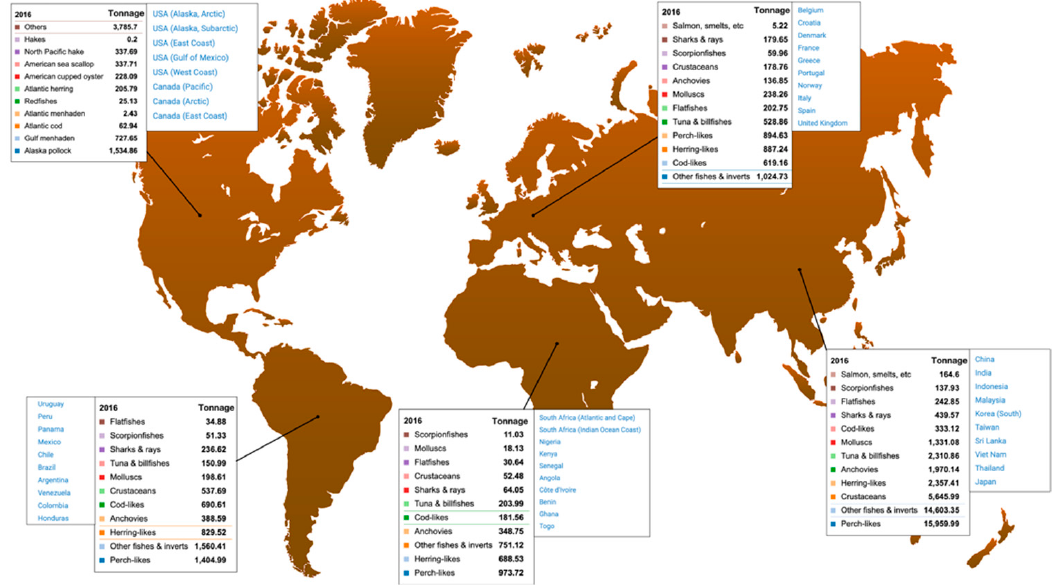
Figure 1. Global seafood production (updated in 2016) according to Pauly et al. [1]. Active bottom-contact gears (e.g., bottom trawls) are widespread large-scale fishing